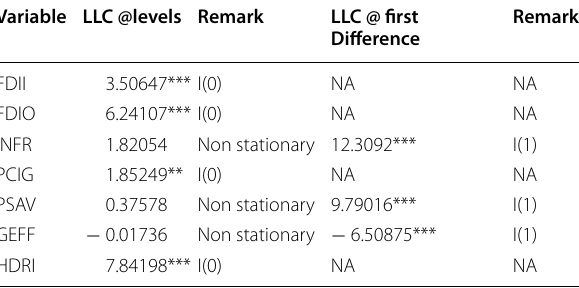
Table 1 Panel Unit Root Result. Source : Computation from World Development Indicator 2022 using E-view